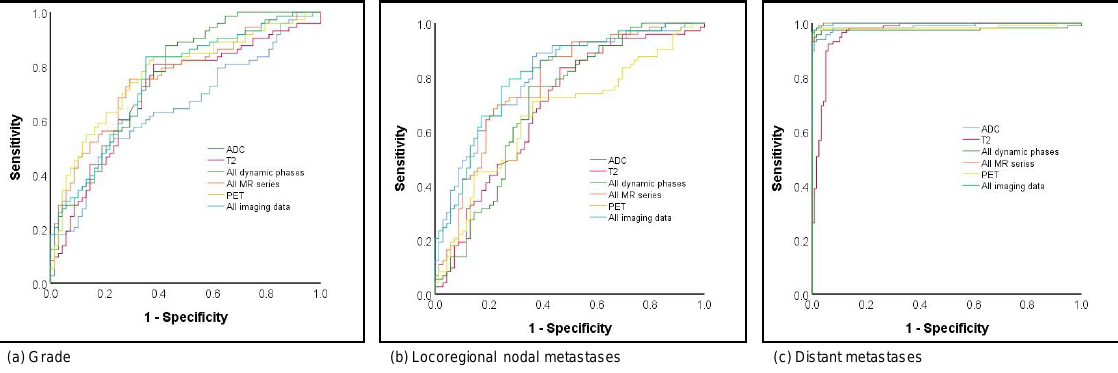
Figure 4. ROC curves for ( a ) grading and ( b ) local as well as ( c ) distant metastatic disease prediction.